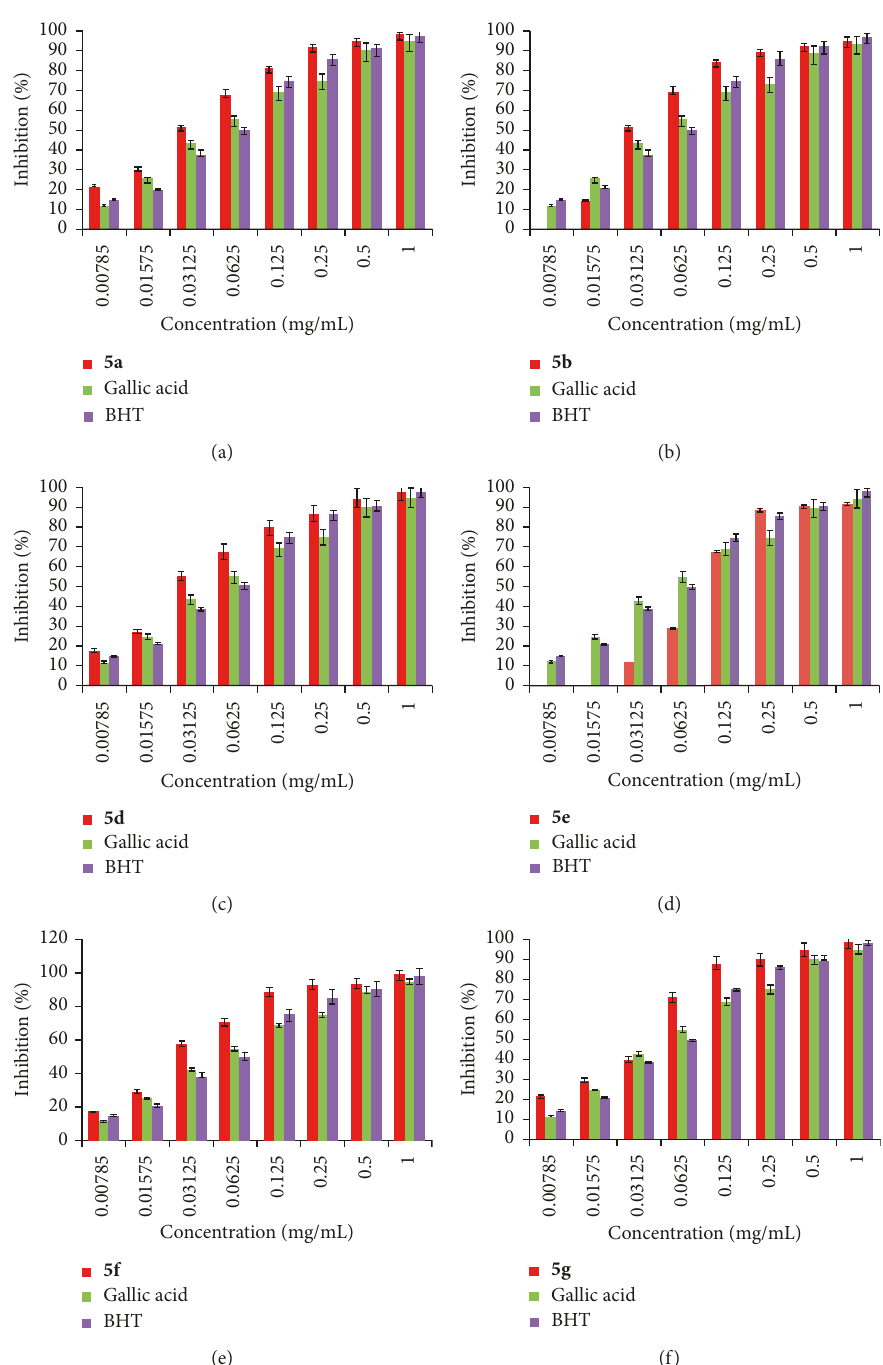
Figure 3: Scavenging activity of benzylpyrazolyl coumarin derivatives 5 on DPPH